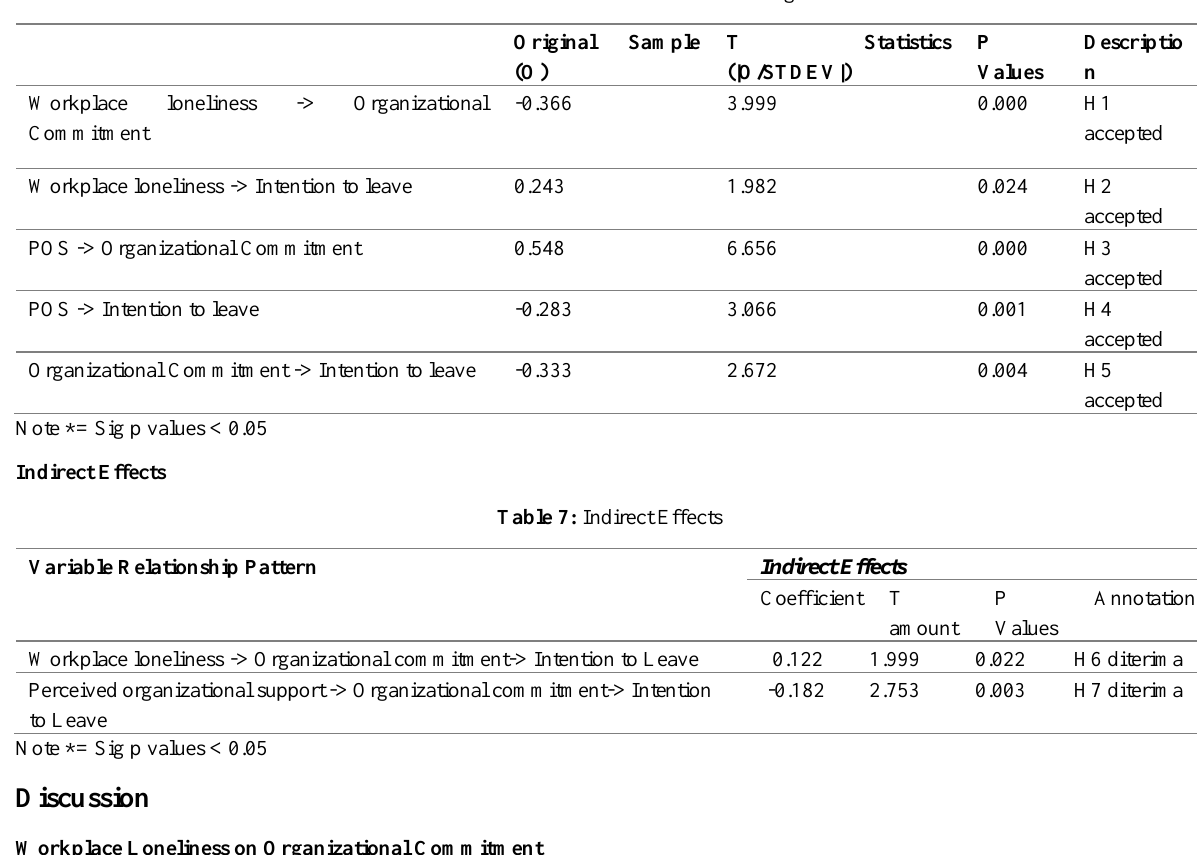
Table 6: Result of Direct Effects Testing